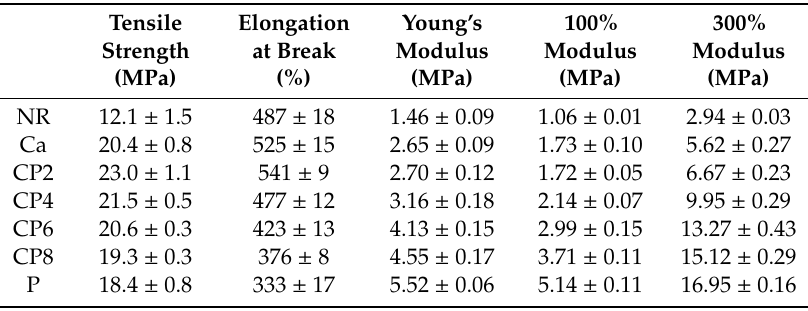
Figure 4. Tensile properties of rubber composites. ( a ) CaCO 3 . ( b ) CaCO 3 modified with stearic acid. Table 2. Tensile Table 2. Tensile Properties.